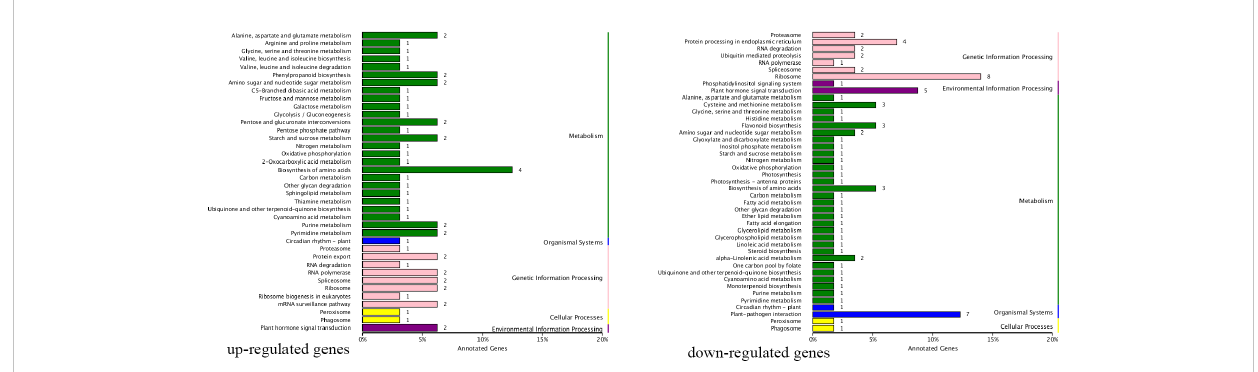
FIGURE 5 Differentially expressed genes enriched in certain KEGG pathways. The number next to each bar represents the number of enriched